Question: In one sentence, what is this figure communicating?
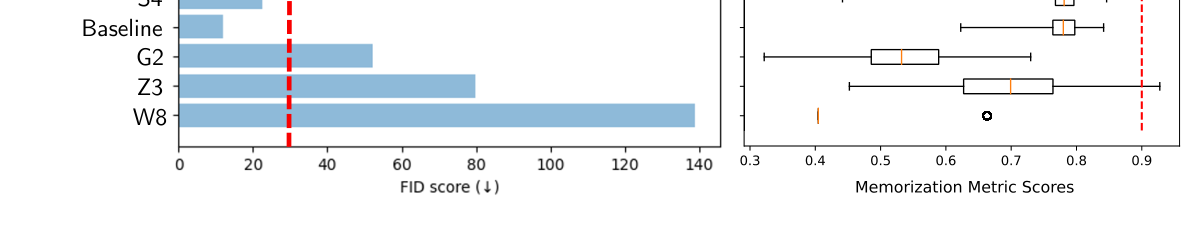
Answer: FID and memorization metric scores for the submissions alongside the FID and memorization metric scores of a baseline StyleGAN2 model trained in-house